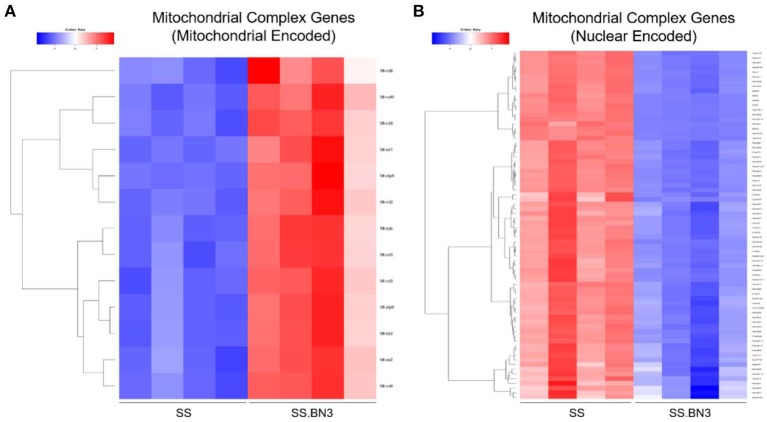
RNA-seq analysis of control SS and SS.BN3 hearts. Total RNA was extracted and RNA-seq was performed on RNA from the left ventricle tissue of adult 10–12 week old female SS and SS.BN3 rats harvested 1 week after mock treatment (N = 4/group). Differential expression analysis was performed, followed by generation of heat maps of (A) 13 mitochondrial encoded genes and (B) 74 nuclear encoded genes differentially expressed at FDR < 0.05 and involved in the mitochondrial complexes that drive oxidative phosphorylation.